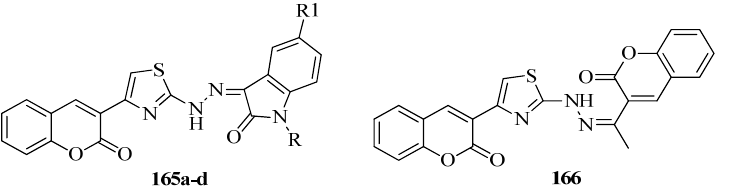
Figure 64. Structures of thiazolyl coumarin derivatives ( 166a , R = H, R’ = H; 166b , R = CH 2 –C 6 H 5 , R’ = H; 166c , R = H, R’ = F; 166d , R = H, R’ = I).